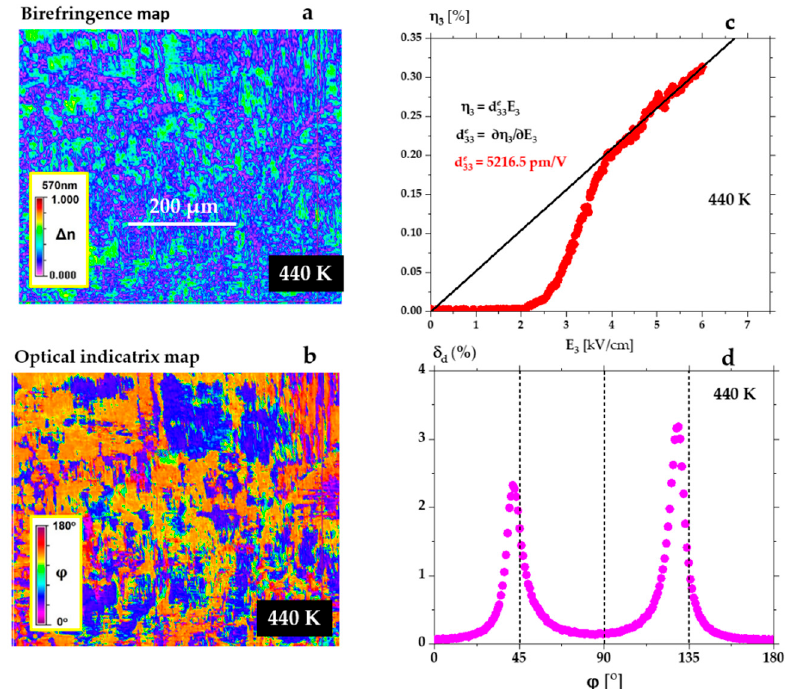
Figure 5. Figures ( a , b ) represent birefringence ∆ n and optical indicatrix φ maps at 440 K at which the ultrahigh piezoelectric coefficient was observed. ( c ) Giant piezoelectric effect recorded at 440 K for increasing electric field amplitude, in a PbZr 0.95 ± 0.01 Ti 0.05 ∓ 0.01 O 3 single crystal. ( d ) Example of domain populations δ d at 440 K after long-time action of the AC field, determined from the map in ( b ). Comparing with Figure 4d shows additional monoclinic orientations in the range of 45° and 135°.